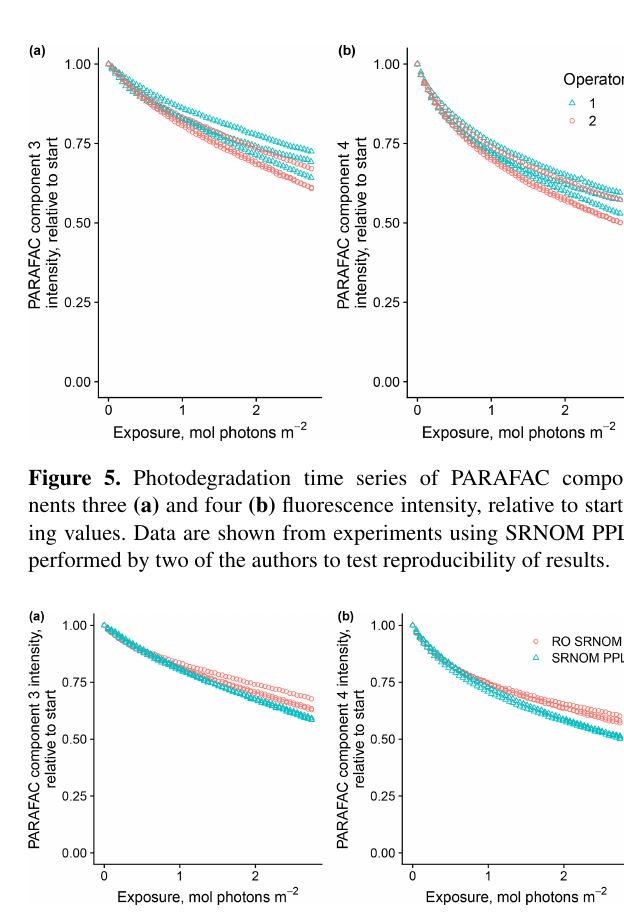
Figure 6. Photodegradation time series of PARAFAC components three (a) and four (b) fluorescence intensity, relative to starting val- ues. Data are shown from three replicates of both RO SRNOM and SRNOM PPL.